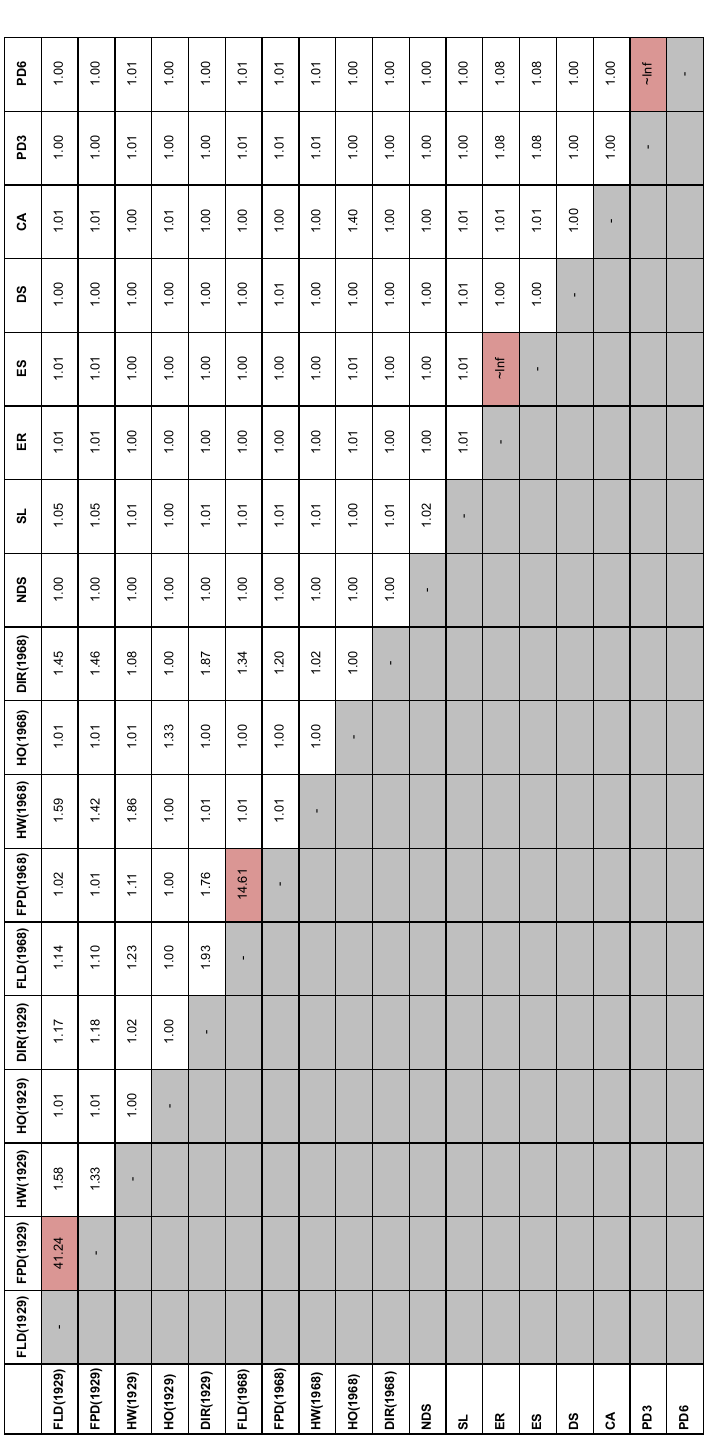
Figure C1. Matrix of variance inflation factors (VIF) for pool of all potential predictor variables. Combinations for which VIF values exceed the threshold of 10 (Kutner et al., 2004) are